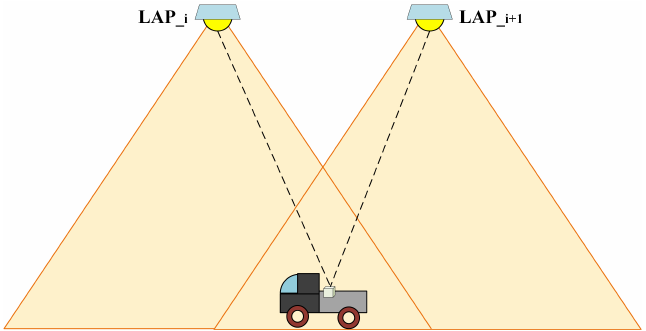
Figure 3. Schematic diagram of